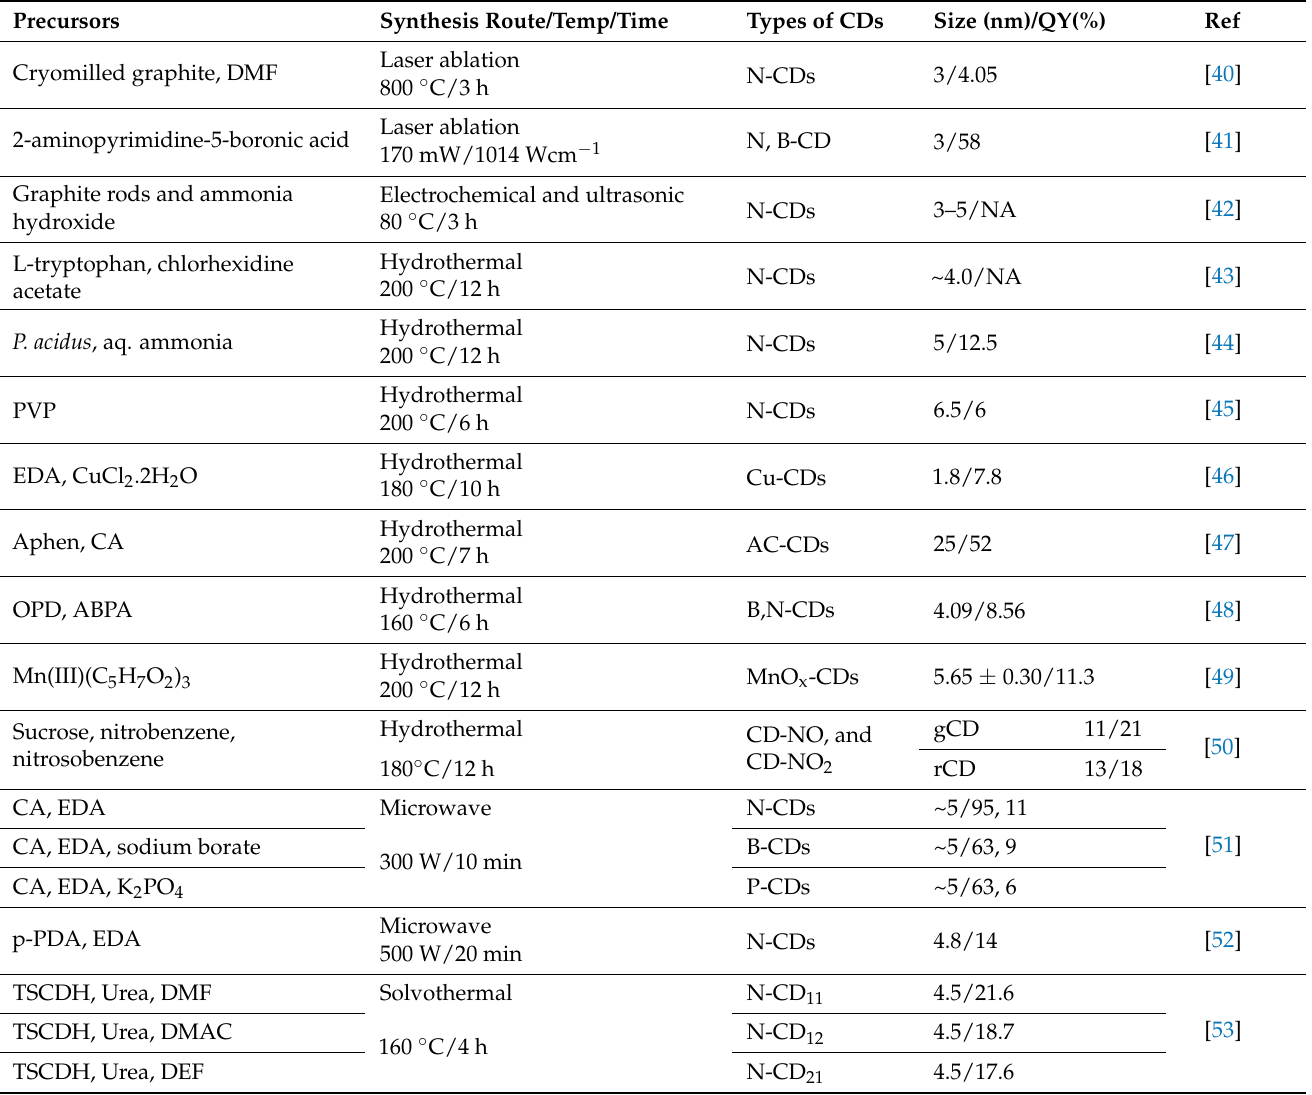
Table 2. Synthesis of heteroatoms doped CDs following top-down and bottom-up